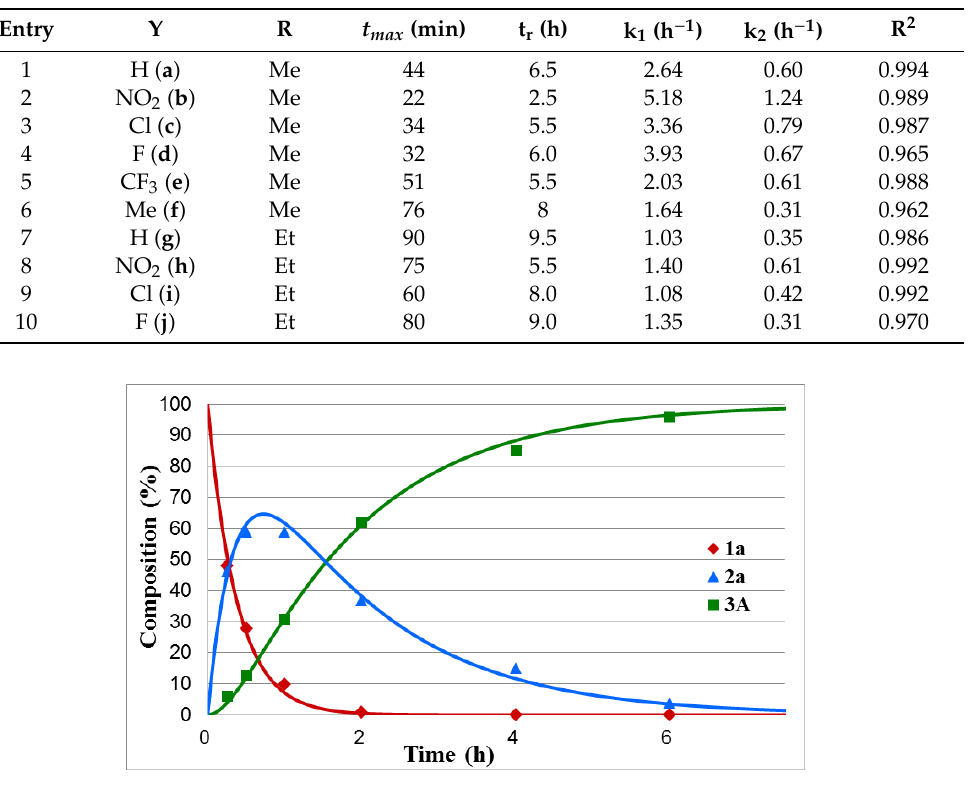
Figure 1. Concentration profile for the components during the hydrolysis of dimethyl α - hydroxybenzylphosphonate ( 1a ) under optimum conditions. The R 2 measure of goodness of fit is 0.994. Figure 2. Concentration profile for the components during the hydrolysis of diethyl α - hydroxybenzylphosphonate ( 1g ) under optimum conditions. The R 2 measure of goodness of fit is 0.986.